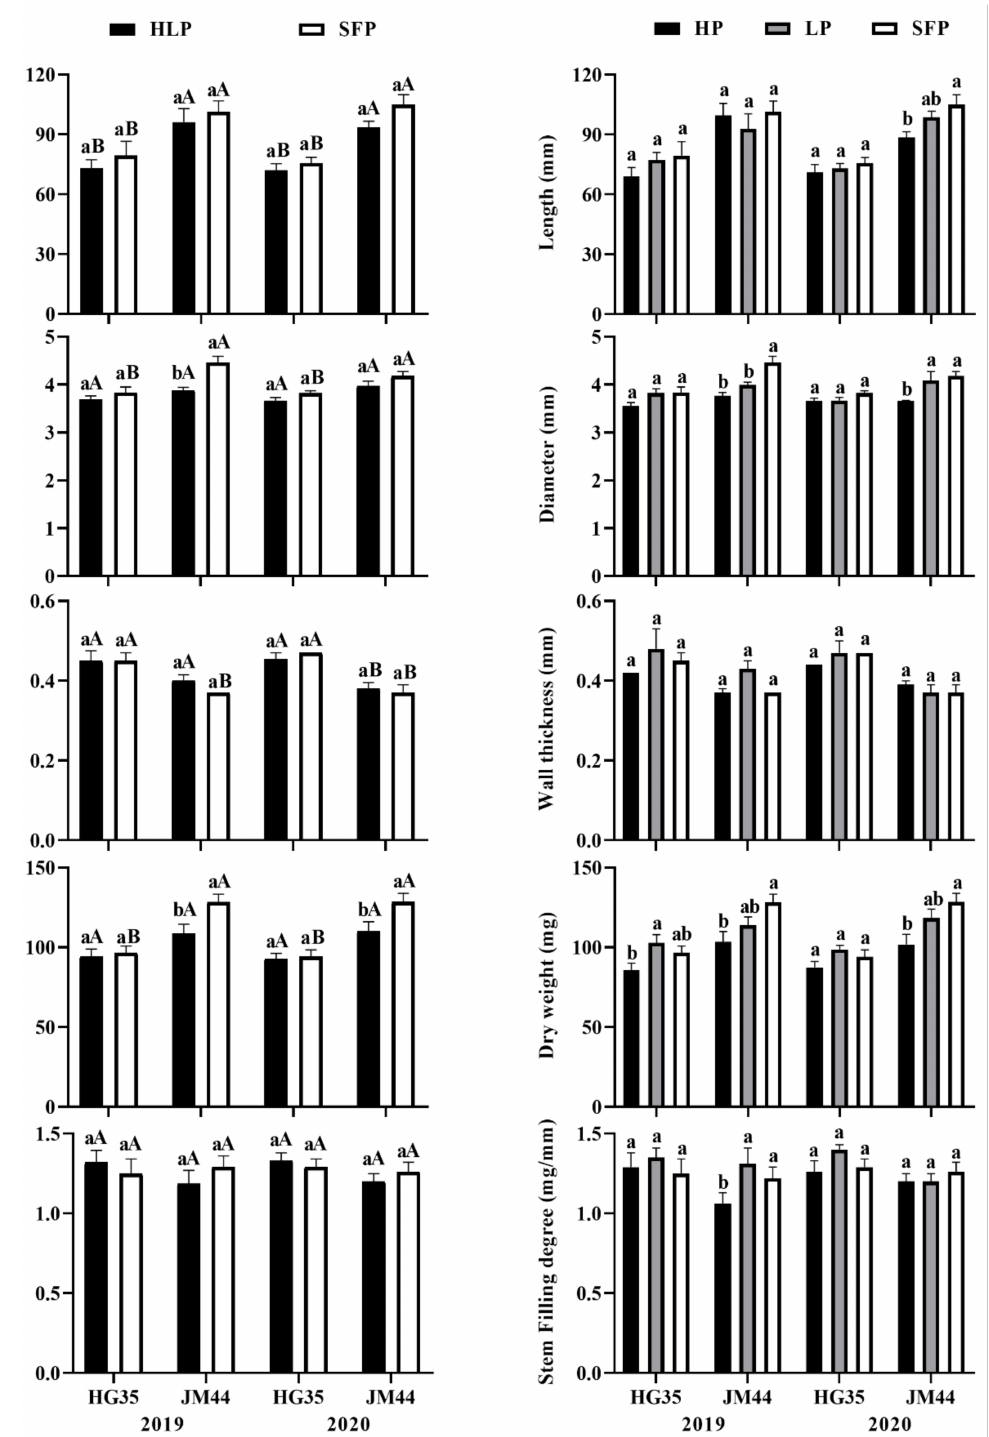
Figure 5. Effects of sowing mode, cultivars, and their interactions on the morphological characteristics of culm second basal internodes. HG35: Hengguan 35; JM44: Jimai 44. HLP: high-low-plot sowing mode; SFP: small-flat-plot sowing mode. The same lowercase letters indicate that the difference between sowing modes was not significant. The same uppercase letters mean the difference between cultivars was not